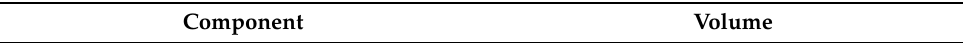
Table 6. First-strand cDNA synthesis reaction